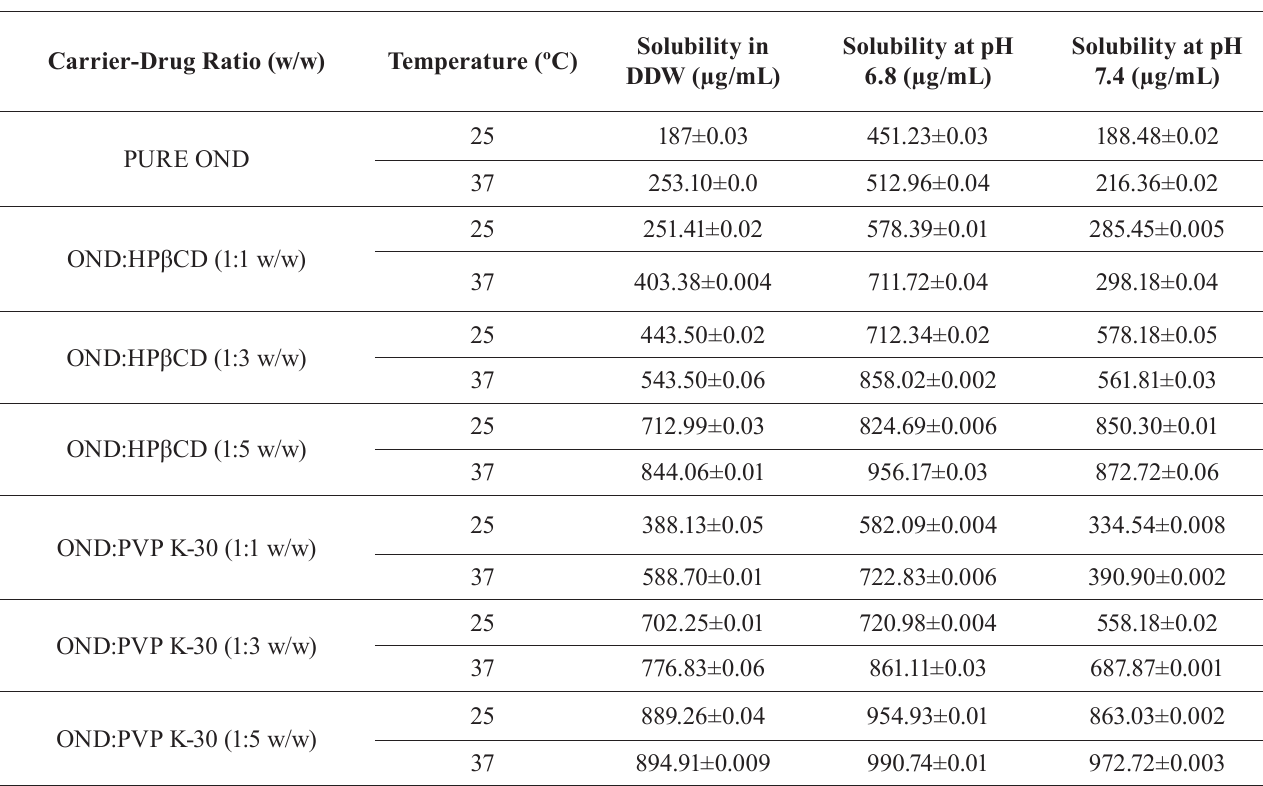
TABLE IV - Solubility study of OND and OND-SD